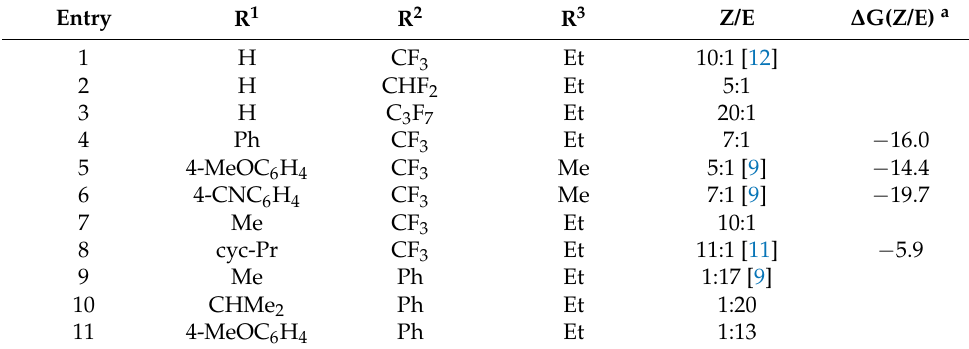
Table 1. The ratio of isomers of iminophosphonates (see Scheme 1).